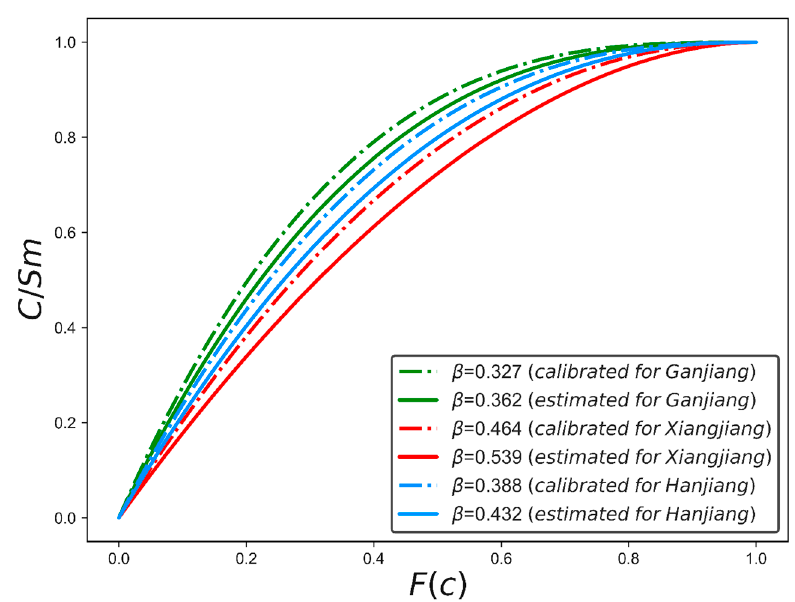
Figure 4. Distributions of soil moisture storage capacity of three study catchments for different values of β based on two different methods (i.e., estimation using SMAP data and model calibration).